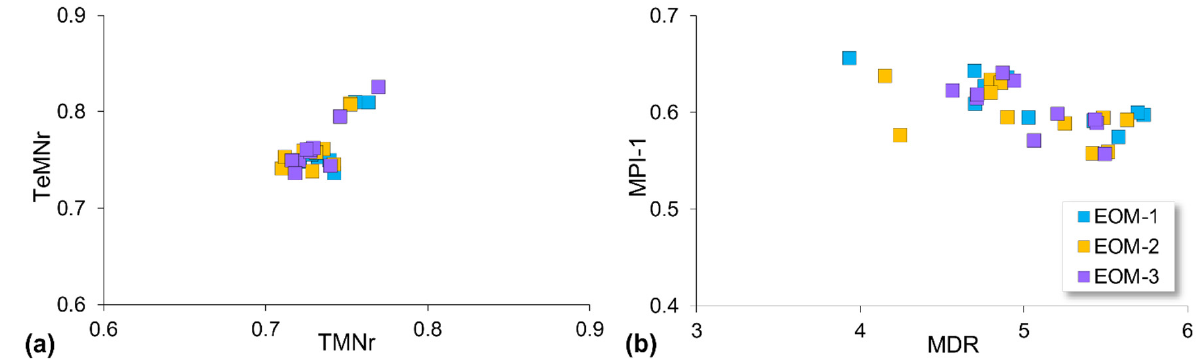
Figure 8. Correlations of maturity parameters derived from aromatic hydrocarbon fraction in sequen- tial extracts of the studied samples: ( a ) TMNr vs. TeMNr; ( b ) MDR vs. MPI-1. The methylphenanthrene index [MPI-1 =1.5 × (2-MP + 3-MP)/(P + 1-MP + 9-MP)] pro-